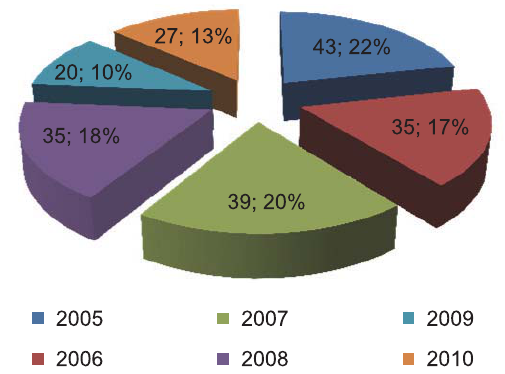
FIGURE 1. Average annual concentrations of NO automatic station spheric pollution by nitrogen oxides was conducted in Sarajevo at the measuring station Bjelave period from period of 2005th to 2010th year. All data are graphs. Th e results are compared with the limit val-